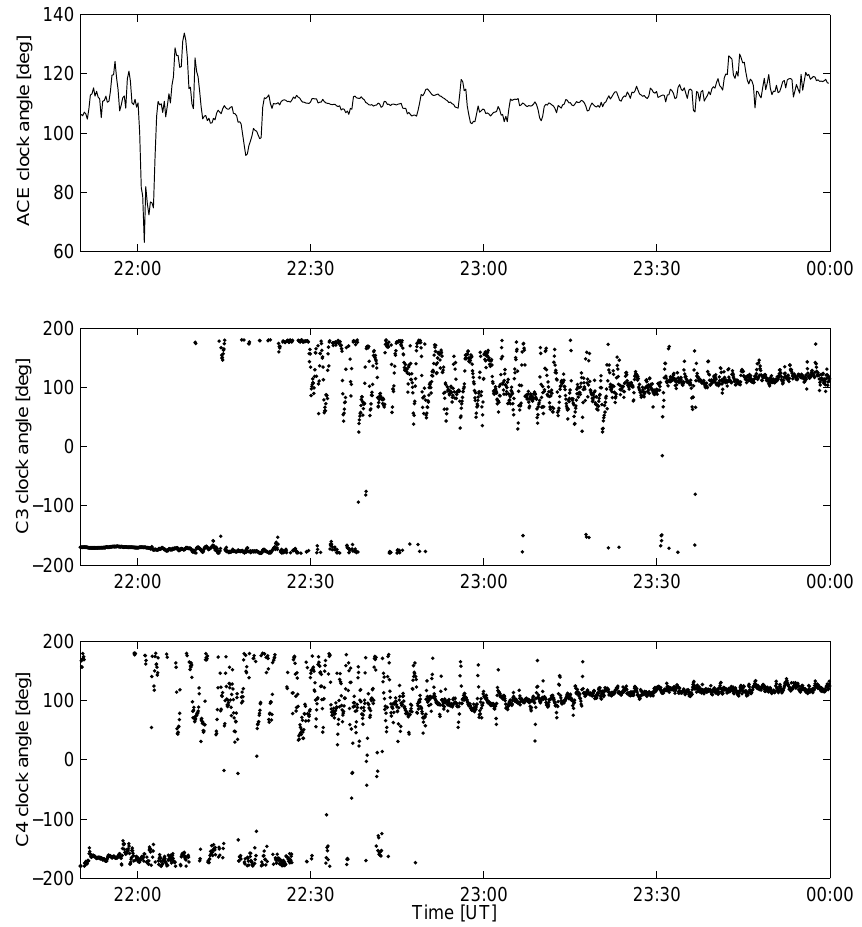
Fig. 3. Clock angles of ACE (delayed by 50min), C3 and C4 satellites.